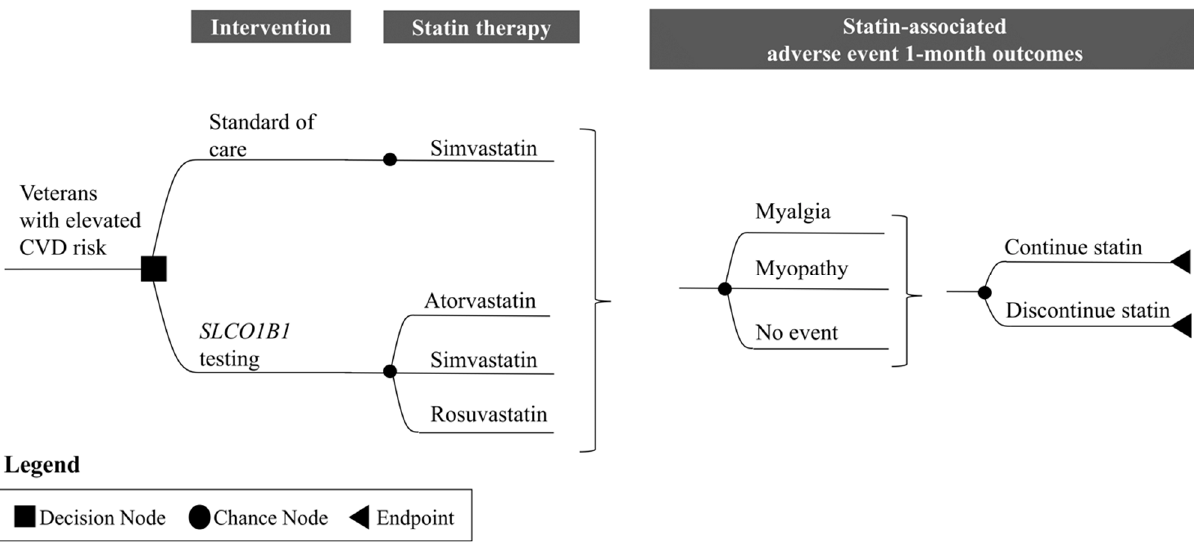
Figure 1. Model structure for 1-month statin therapy and statin-associated adverse events. (adapted from Dong et al., Value Health , 2020 [30]). A total of 10,000 simulated veterans with elevated cardiovascular disease risk are entered into the decision analytic model and are assigned to standard of care (no testing) and to SLCO1B1 testing. Statins can be offered and initiated in both testing strategies. Statin therapy options include atorvastatin, simvastatin, and rosuvastatin. After one month of being on statin therapy, the presence of a myalgia and myopathy may occur, which may lead to discontinuation of the statin. Abbreviations: CVD, cardiovascular disease.